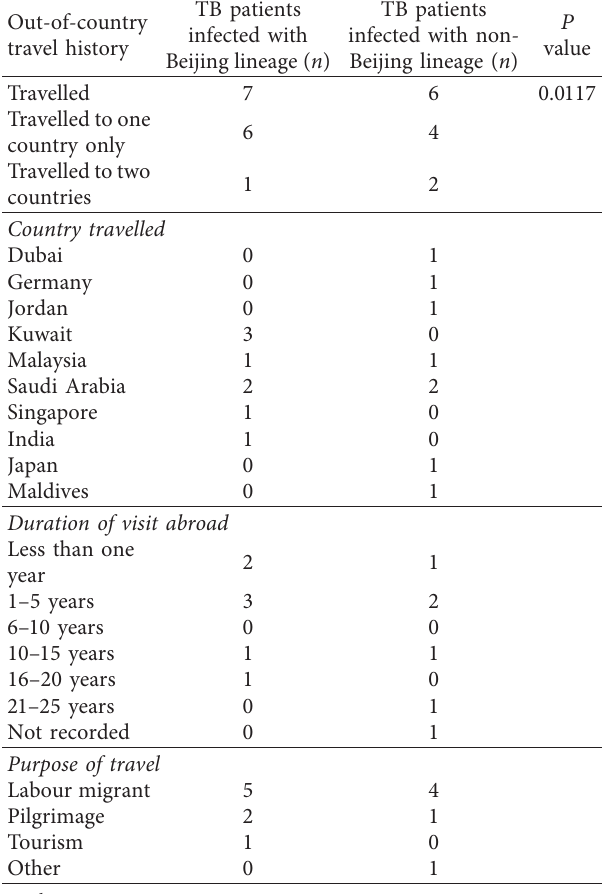
Table 2: Out-of-country travel information of TB patients diag- nosed in a tertiary care hospital in Kandy, Sri Lanka, between February 2018 and March 2019 disaggregated by their Beijing lineage strain status.